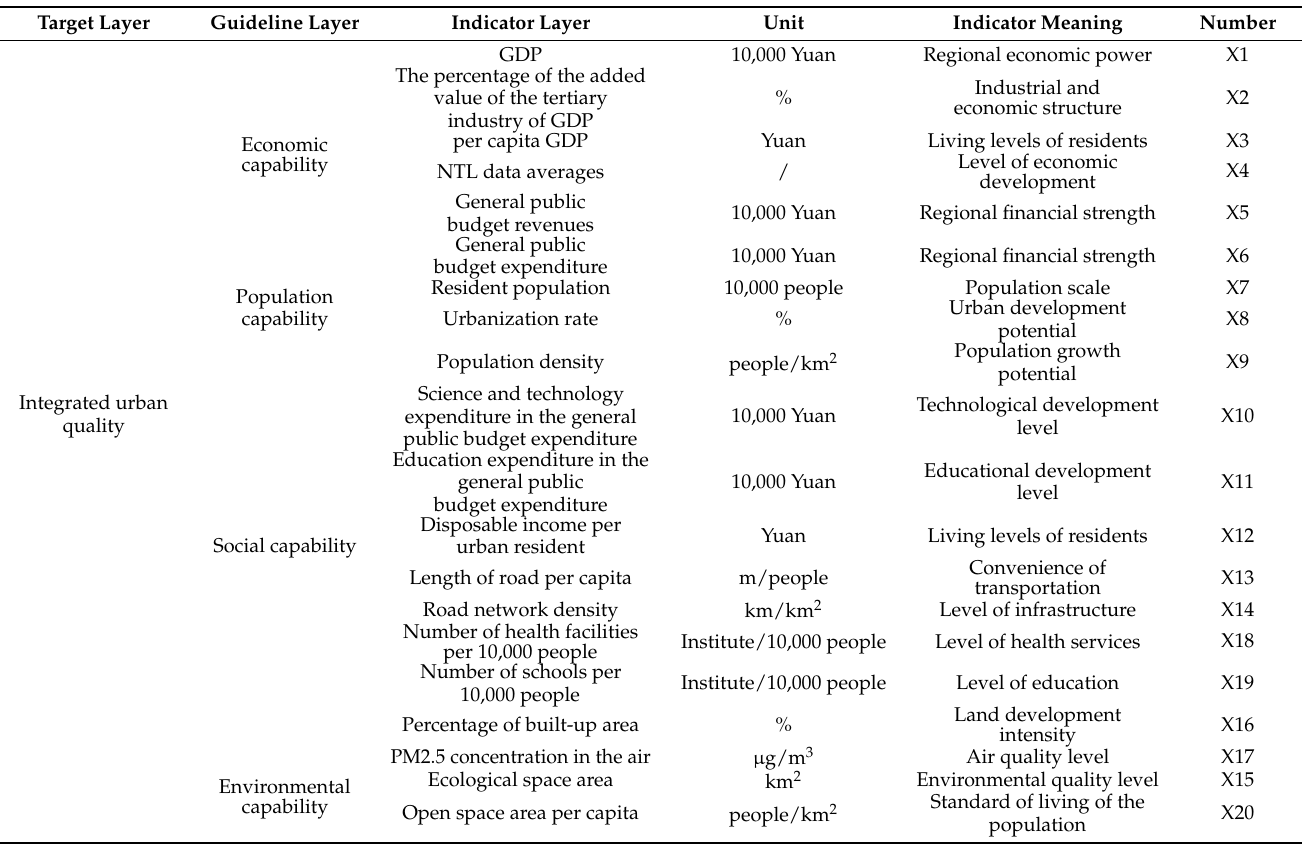
Table 1. Integrated urban quality evaluation indicator system.